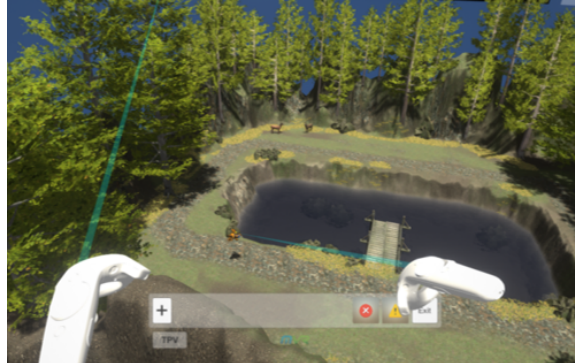
Figure 14. Virtual controller and laser pointer rendered on the HMD of the remote expert.